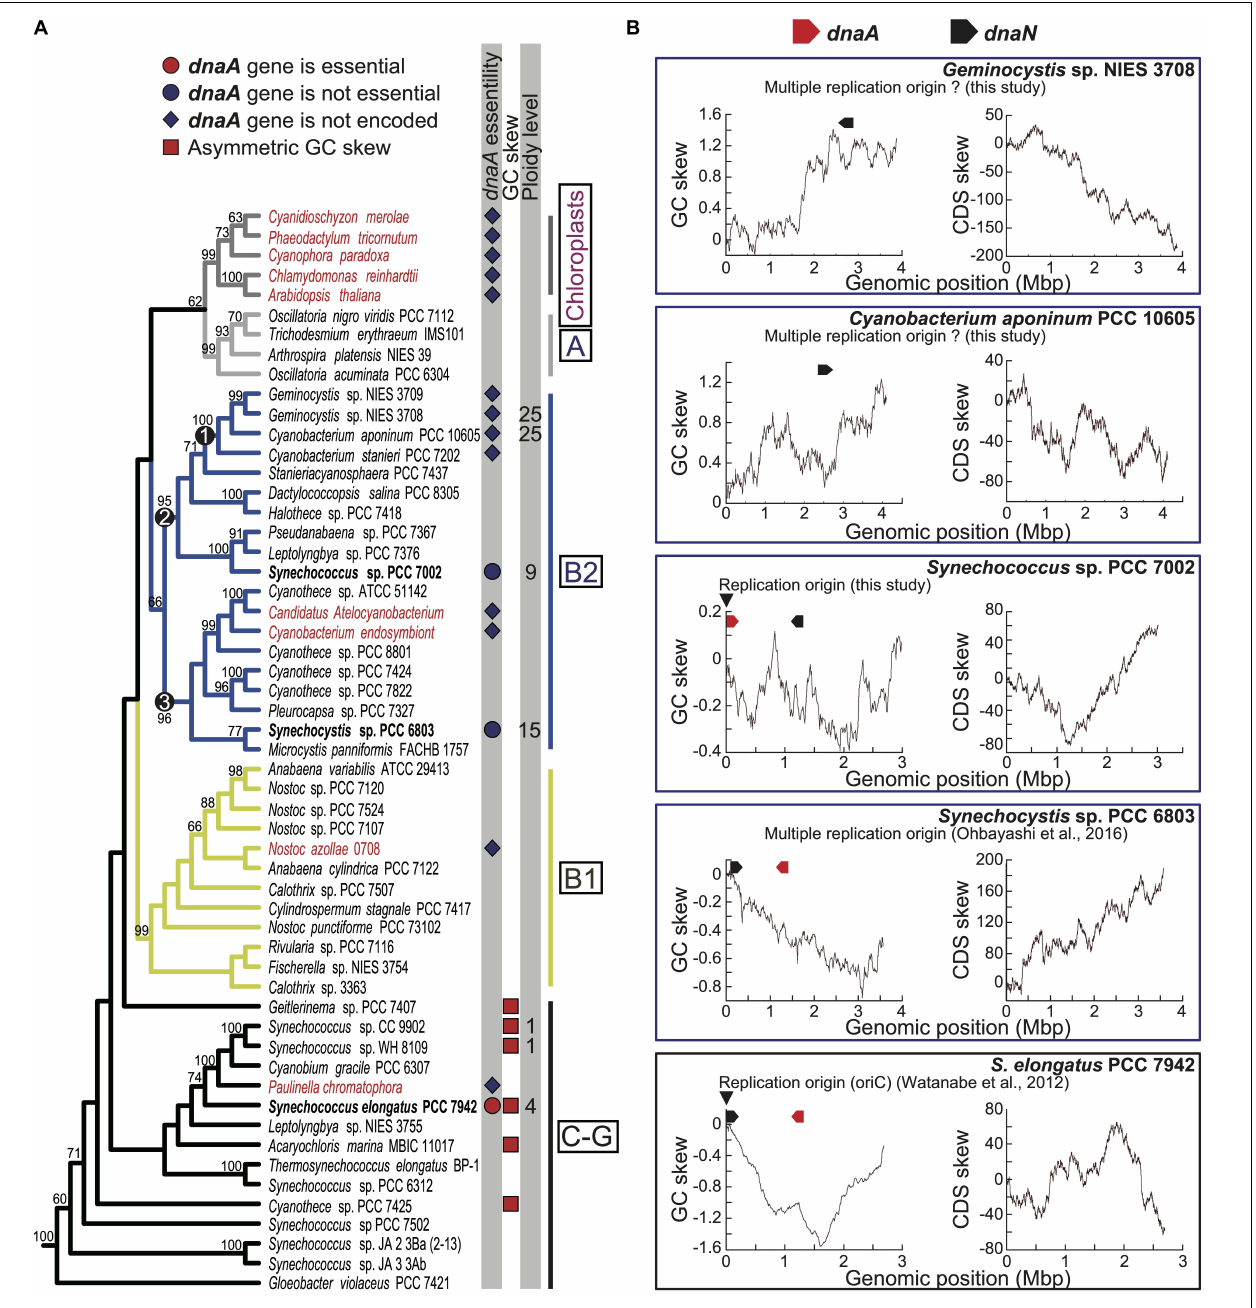
FIGURE 1 | Phylogenetic distributions of dnaA among cyanobacterial and chloroplast genomes and GC and CDS skew profiles of chromosomes. (A) Phylogenetic relationships of cyanobacteria and chloroplasts and presence or absence of genomic dnaA . The tree was constructed using a maximum likelihood method based on 58 concatenated rDNA sequences (16S + 23S + 5S rDNA). Bootstrap values > 50% are shown above the selected branches. The full tree with the outgroup and accession numbers of respective nucleotide sequences are indicated in Supplementary Figure S1 . Clades A, B1, B2, and C-G are defined according to a previous study (Shih et al., 2013). Chloroplasts and symbiotic species are shown in red, and free-living species are shown in black. The red or blue circle next to the species name indicates that dnaA was experimentally shown as essential or not essential for chromosome replication in the species (Ohbayashi et al., 2016; present study). The blue diamond next to the species name indicates the absence of dnaA . The red square next to the species name indicates that the chromosomal genome exhibits a clear asymmetric (V-shaped) GC skew profile. (B) Cumulative GC and CDS skew profiles of the chromosome of Geminocystis sp. NIES-3708, Cyanobacterium aponinum PCC 10605, Synechococcus sp. PCC 7002, Synechocystis sp. PCC 6803, and Synechococcus elongatus (profiles of other species are shown in Supplementary Figures S4 , S5 ). The positions of dnaA and dnaN are indicated above the profiles. The arrowheads indicate the experimentally determined replication origins of Synechococcus sp. PCC 7002 (this study) and S . elongatus (Watanabe et al., 2012). The chromosome of Synechocystis sp. PCC 6803 is replicated from multiple origins (Ohbayashi et al., 2016).